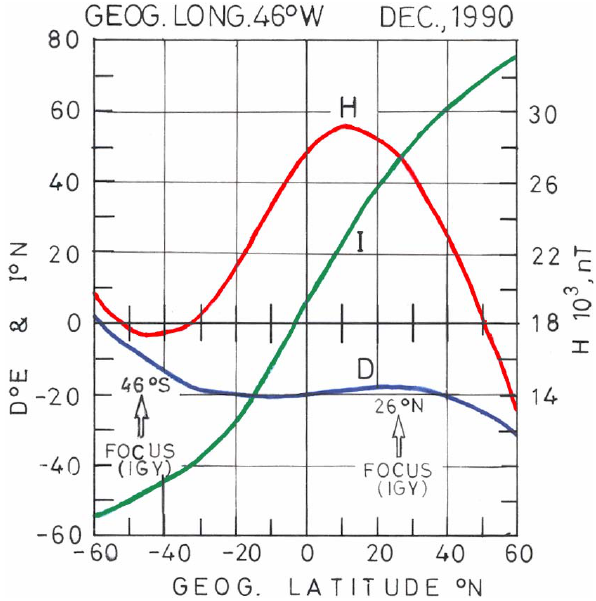
Fig. 15. Variation with geographic latitude of magnetic field com- ponents Horizontal field ( H ), Declination ( D ) and Inclination ( I ) along 46 ◦ W